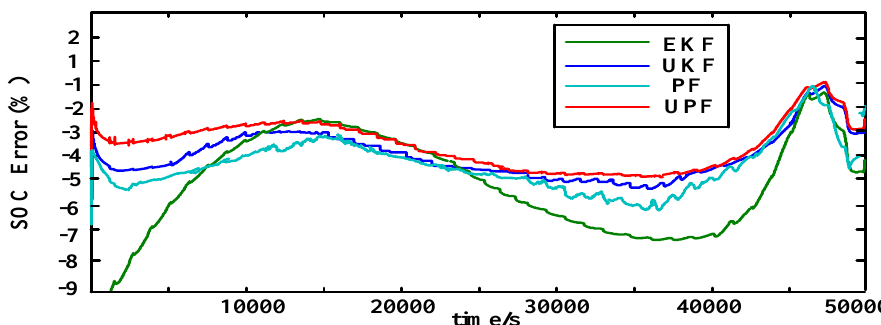
Figure 17. SOC estimation error curves of di ff erent algorithms under open-circuit voltage disturbances. Table 9. Maximum Estimation Error of Di ff erent Algorithms under open-circuit voltage disturbances. Algorithm EKF UKF Maximum estimation error